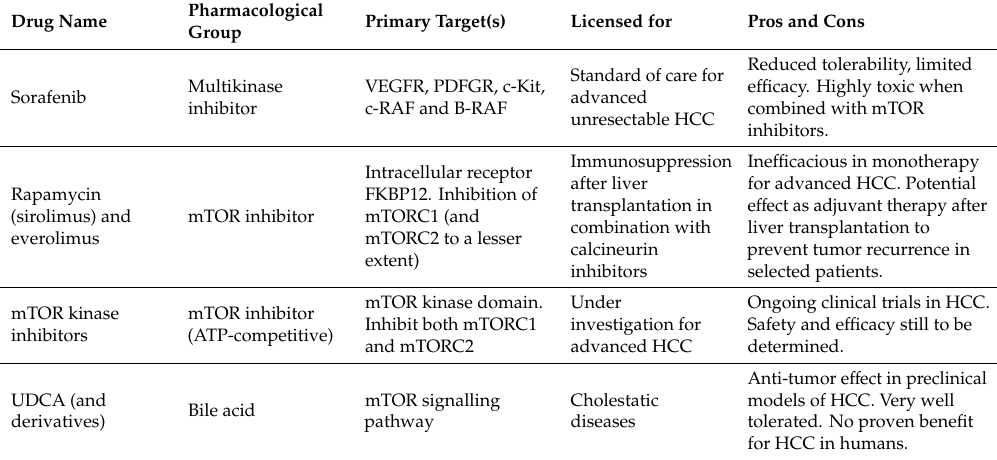
Table 1. Chemical compounds a ff ecting the mTOR signaling pathway currently used or under investigation in chronic liver diseases and hepatocellular carcinoma